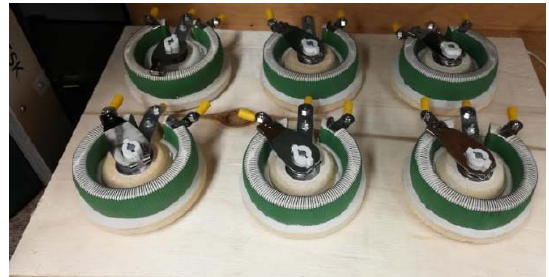
Figure 11. Ultracapacitors used in the electric test bench.